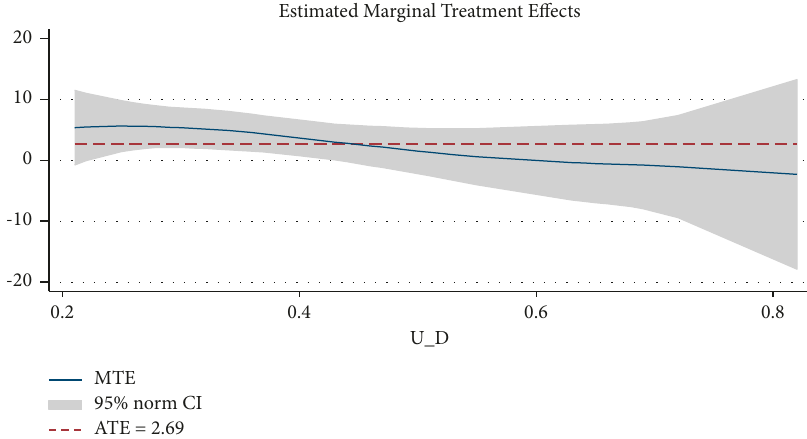
Figure 2: Marginal Treatment Effect over the Common Support of p